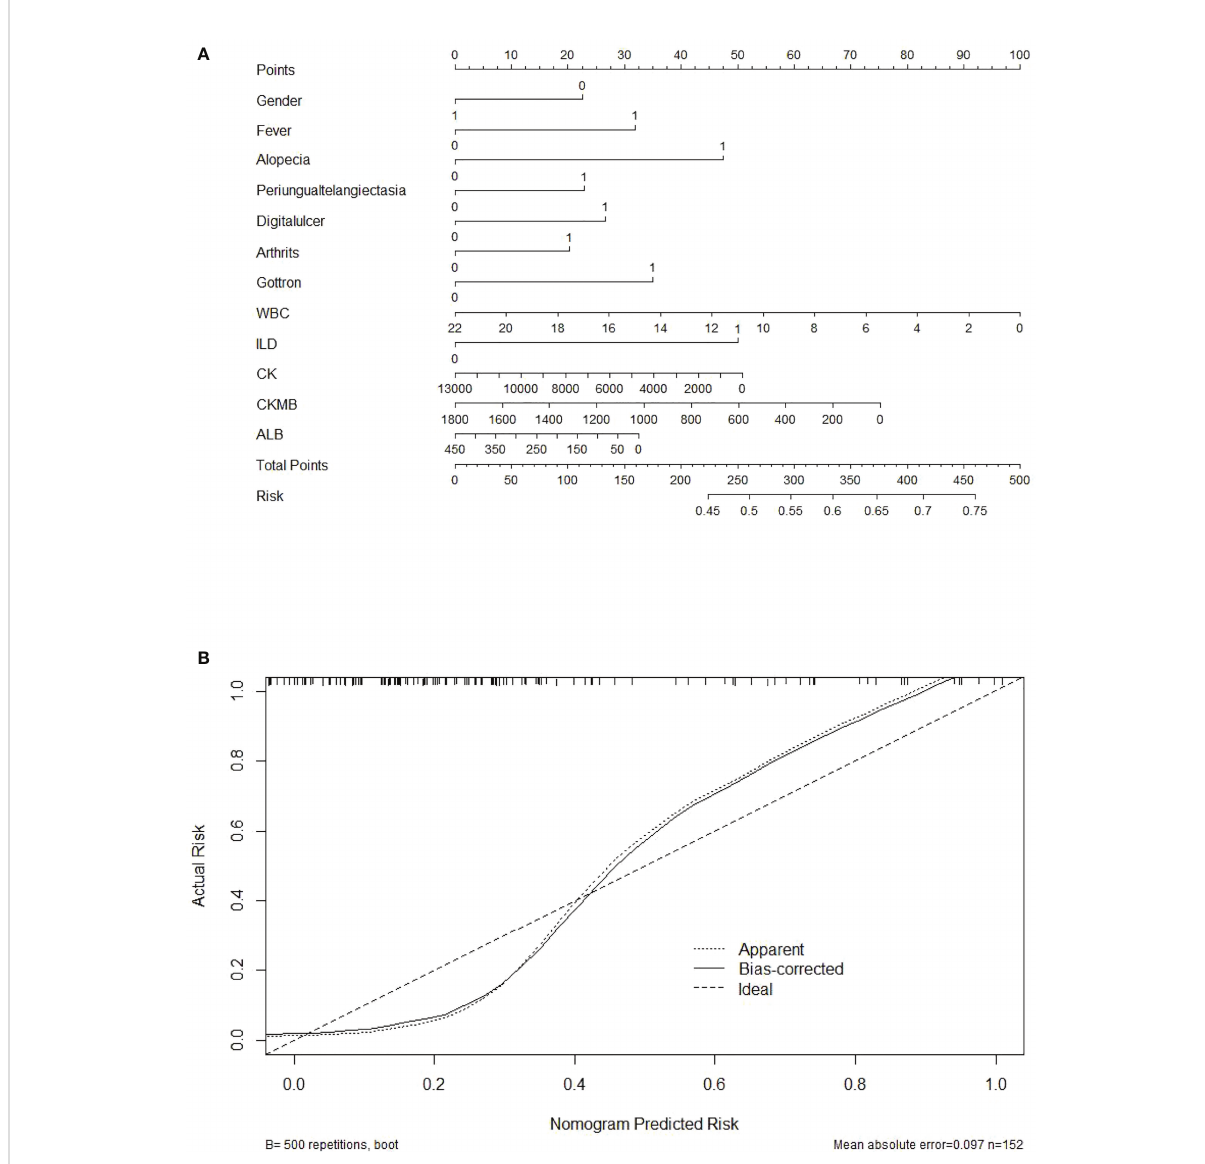
FIGURE 5 Nomogram and the calibration curve for the anti-MDA5 prediction model. (A) Nomogram predicting the probability that a JDM patient will be detection positive for anti-MDA5 antibodies. Points for 12 screened variables can be obtained using a point caliper and then summed to obtain a total score that can be matched with the risk. (B) Calibration curve of the prediction model by the actual risk with 500 bootstraps. Broken line represents apparent prediction; solid line represents the performance of the corrected prediction model. A smaller distance between the scatter point and the broken line indicates a better